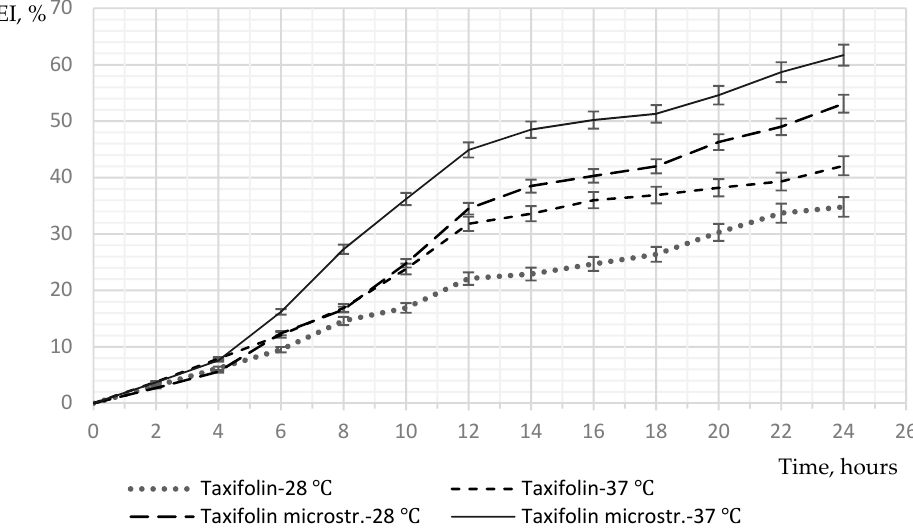
Figure 5. Dynamics of encapsulation of taxifolin samples in yeast cells.